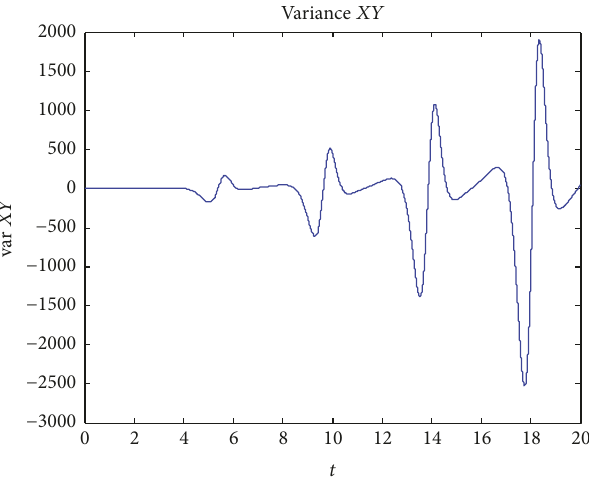
Figure 6: Trajectory of the covariance 𝑞 12 (𝑡) = E {𝑋(𝑡)𝑌(𝑡)} . Phase diagram for “var X ; var Y ”